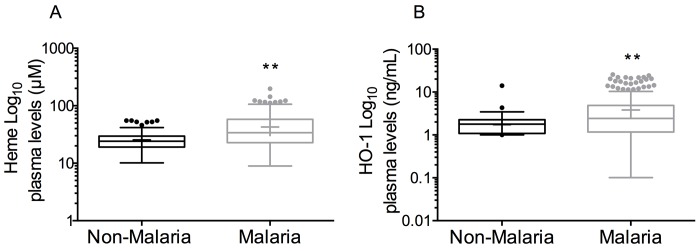
Plasma heme and HO-1 levels increase in malaria patients.(A) Malaria patients have increased expression of plasma heme (p < 0.0001) and (B) Heme Oxygenase-1 (HO-1) (p < 0.0001) compared to non-malaria subjects. Box plots representing medians with 25th and 75th percentiles, bars for 10th and 90th percentiles, and points for outliers of biomarker concentrations. Means indicated by (+) sign. Statistically significant p-values after Bonferroni adjustment are shown, n = 411. Normal range of 0–60 μM heme and 0–4 ng/mL HO-1 observed in non-malaria subjects.